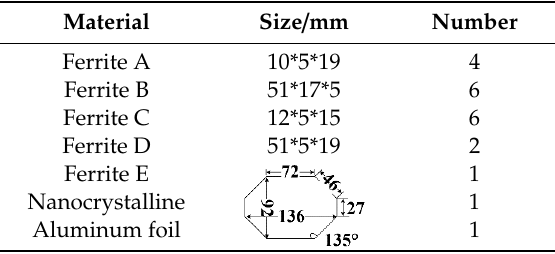
Table 2. Geometry parameters of shielding material.